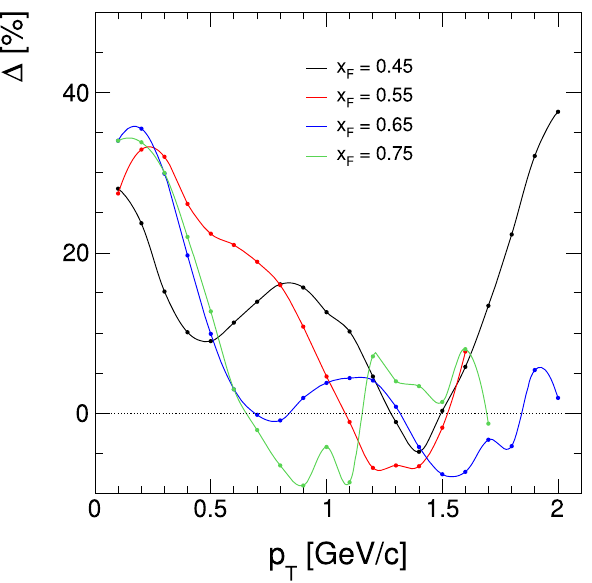
Fig. 191 Percent difference Δ between data and resonance prediction as a function of x F for p T = 1.3, 1.5, 1.7. 1.9 and 2.0 GeV/c Fig. 189 Percent deviation between data and resonance sum as a func- tion of p T for x F = 0.45, 0.55, 0.65 and 0.75 as discussed above have to be confronted with the cascading decay The low p T /low x F enhancements are reminiscent of the R → R (cid:3) + h decay of low- Q resonances without Breit–Wigner tails, see ( R and R (cid:3) - resonances, h - final state hadron) (75) Fig. 158. In this context the resonance decays into final-state hadrons Some examples for (75) have been evoked in Sect. 19.1, (72) and (73). Whereas in (74) the Breit–Wigner tail of the R → h 1 + h 2 decaying resonance comes fully into play, Sect. 16, the cas- ( R - resonance, h cading decays like (75) have been shown to damp the 1 and h 2 - final state hadrons) (74)